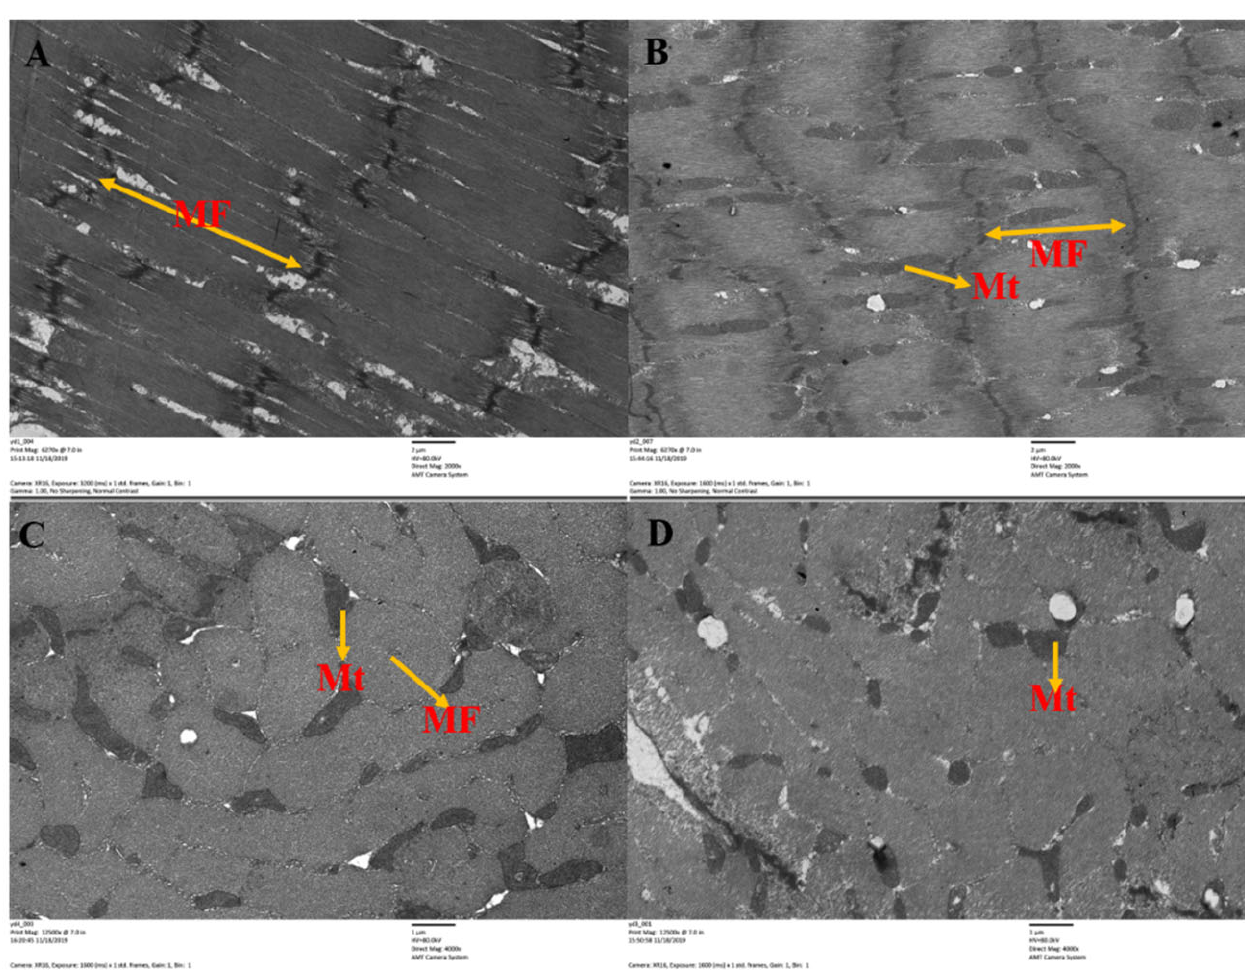
Figure 5. Longitudinal and cross-sectional views of flight muscles in BPH adult females fed on drought-stressed and non-stressed rice. Longitudinal section of flight muscles in ( A ) non-stressed female adults and ( B ) drought-stressed female adults ( × 6270). Cross-sectional view of flight muscles in ( C ) non-stressed female adults and ( D ) drought-stressed female adults ( × 12,500). Abbreviations: MF—myofibril; Mt—mitochondria.